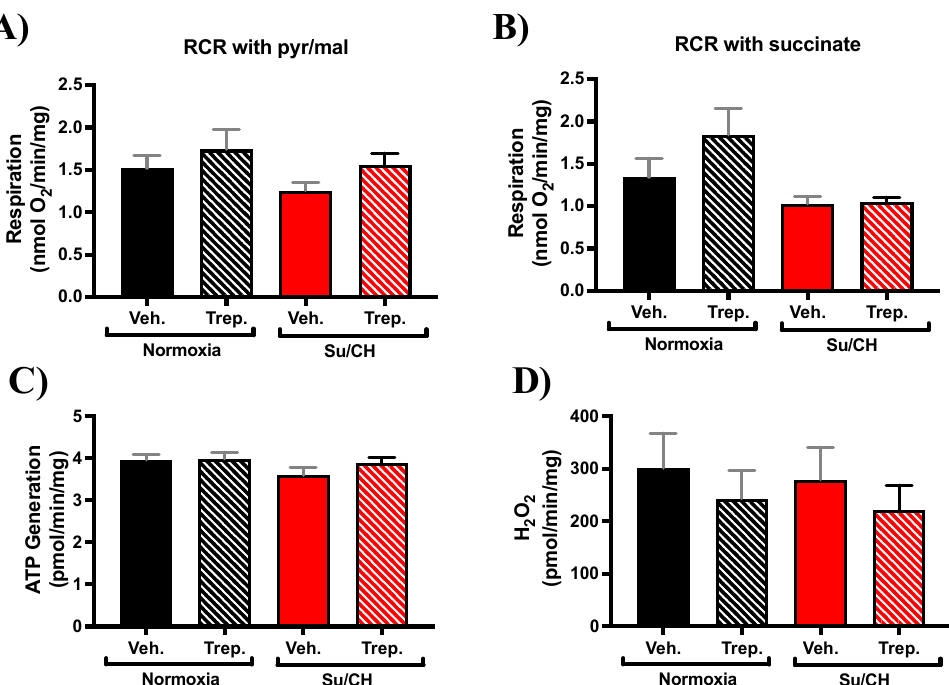
Figure 4. RV mitochondrial function in PAH rat model of SuCH. Bar graphs present isolated RV mitochondria respiratory rate in the presence of ( A ) pyruvate/malate or ( B ) succinate as substrates with ADP, ( C ) ATP generation, and ( D ) hydrogen peroxide (H 2 O 2 ) production; n = 3–8 animals/experimental group.